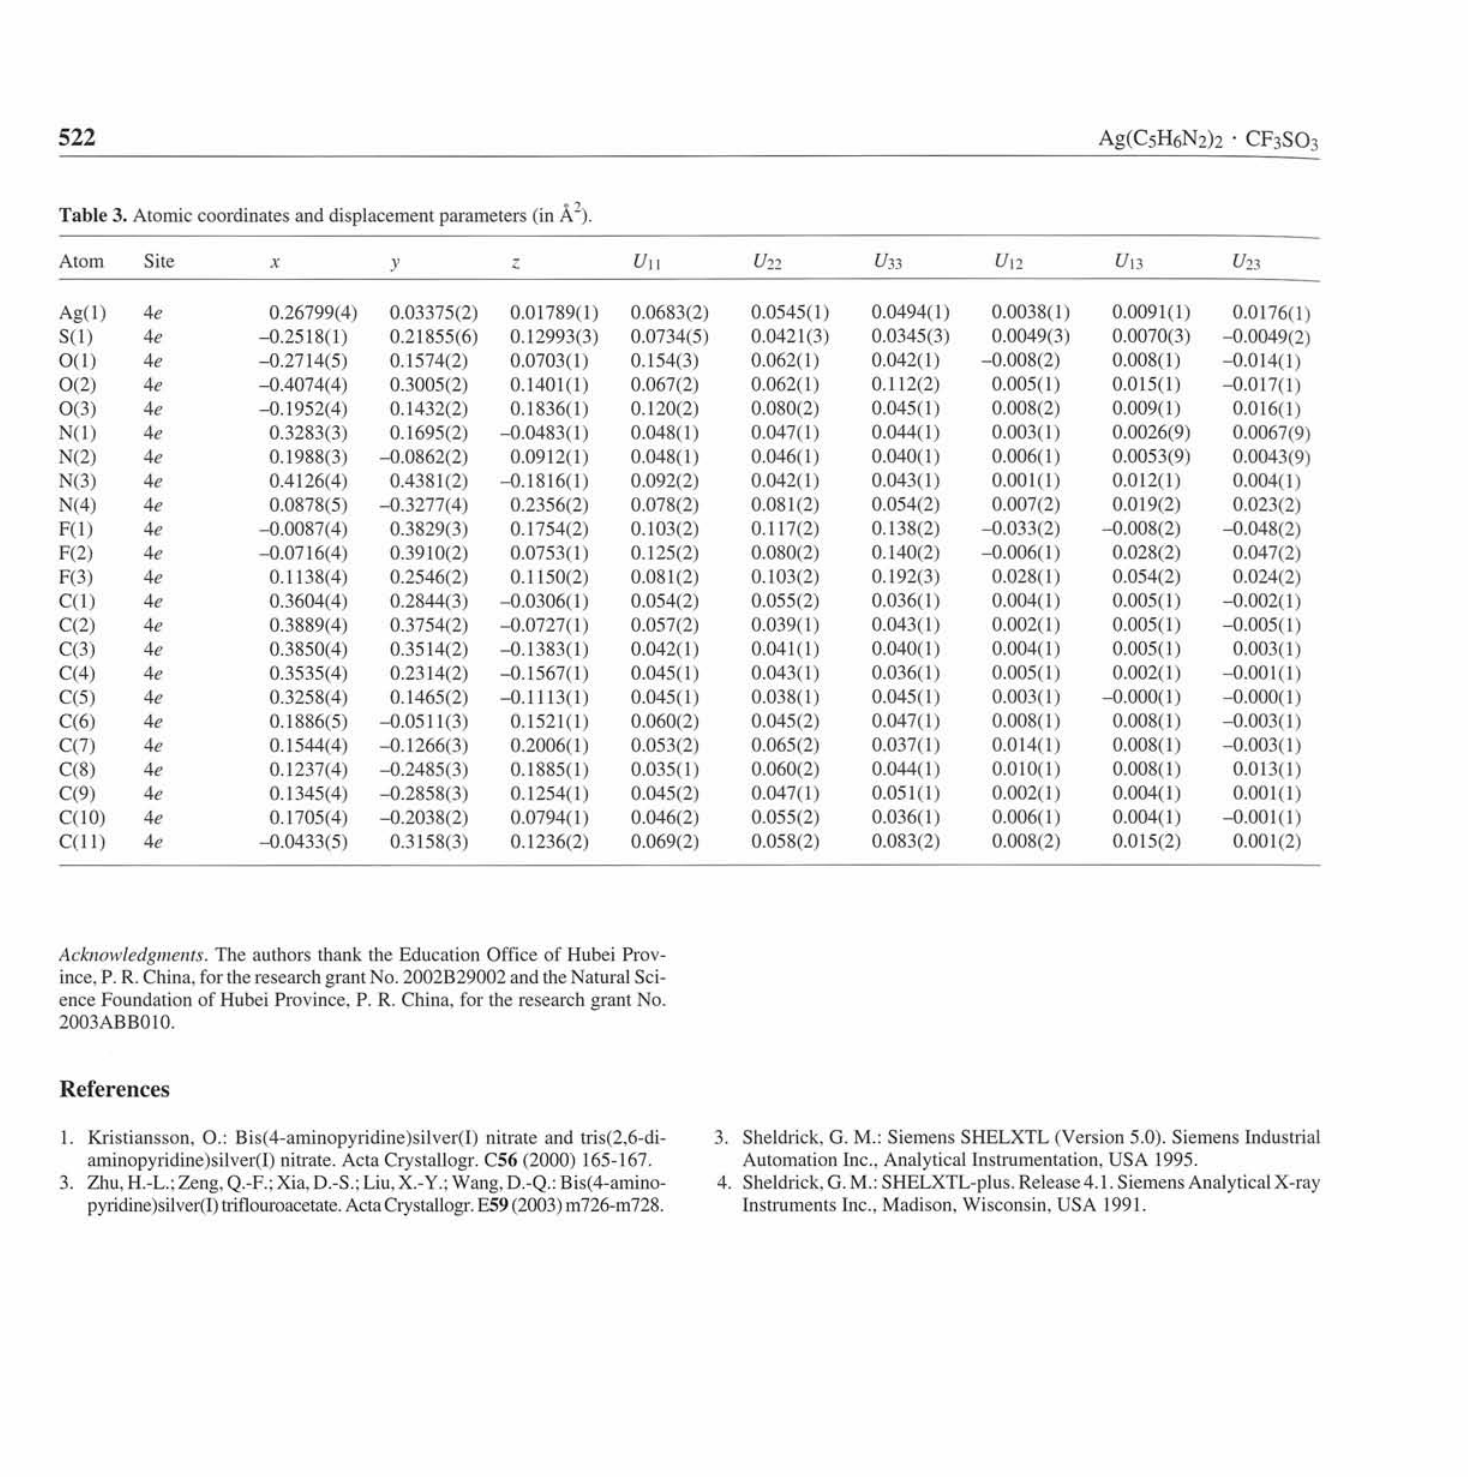
Table 3. Atomic coordinates and displacement parameters (in Â 1